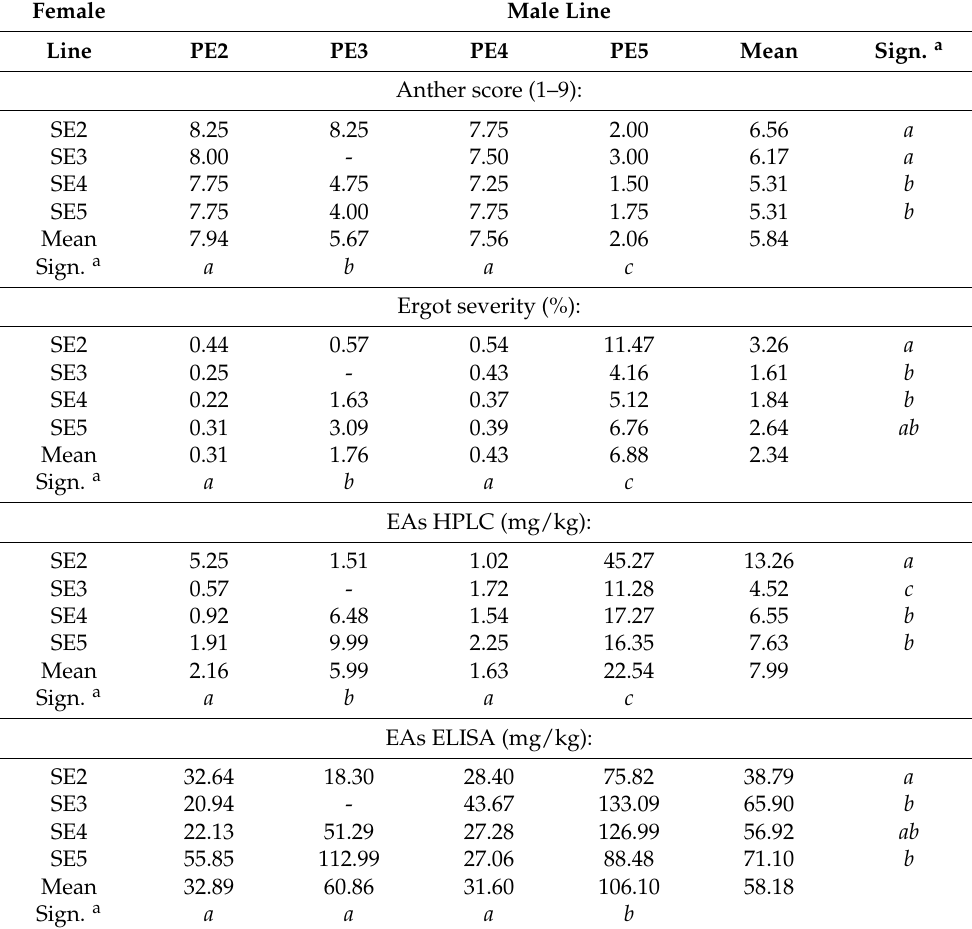
Table 1. Means of anther score (1–9), ergot severity (%), and ergot alkaloid (EA) contents determined by HPLC and ELISA (mg/kg) across two environments for the combination of four female CMS lines and four male lines after inoculation by Claviceps purpurea .